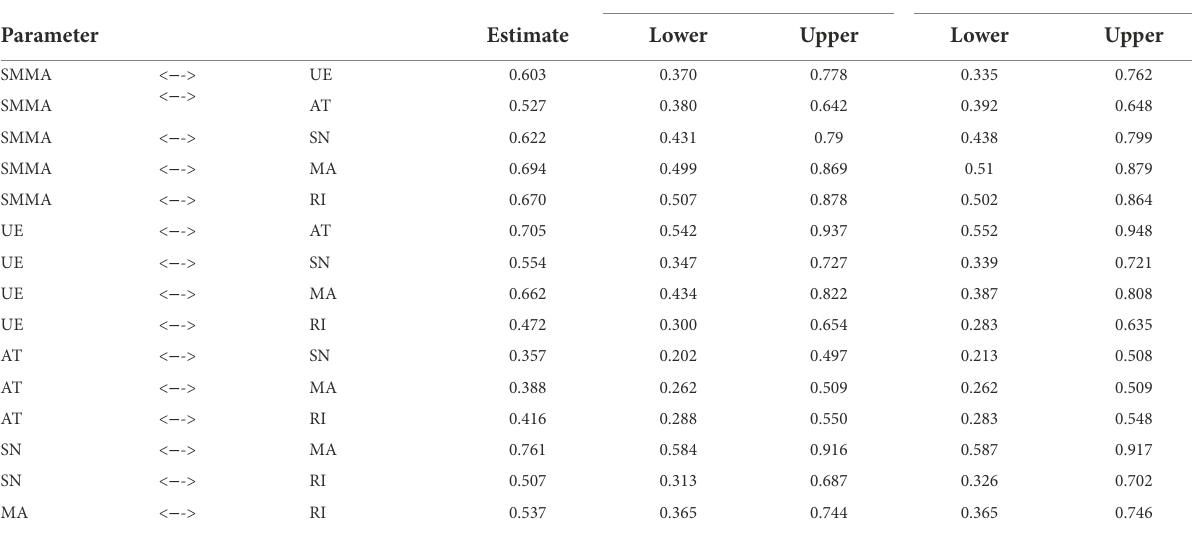
TABLE 4 Discriminant